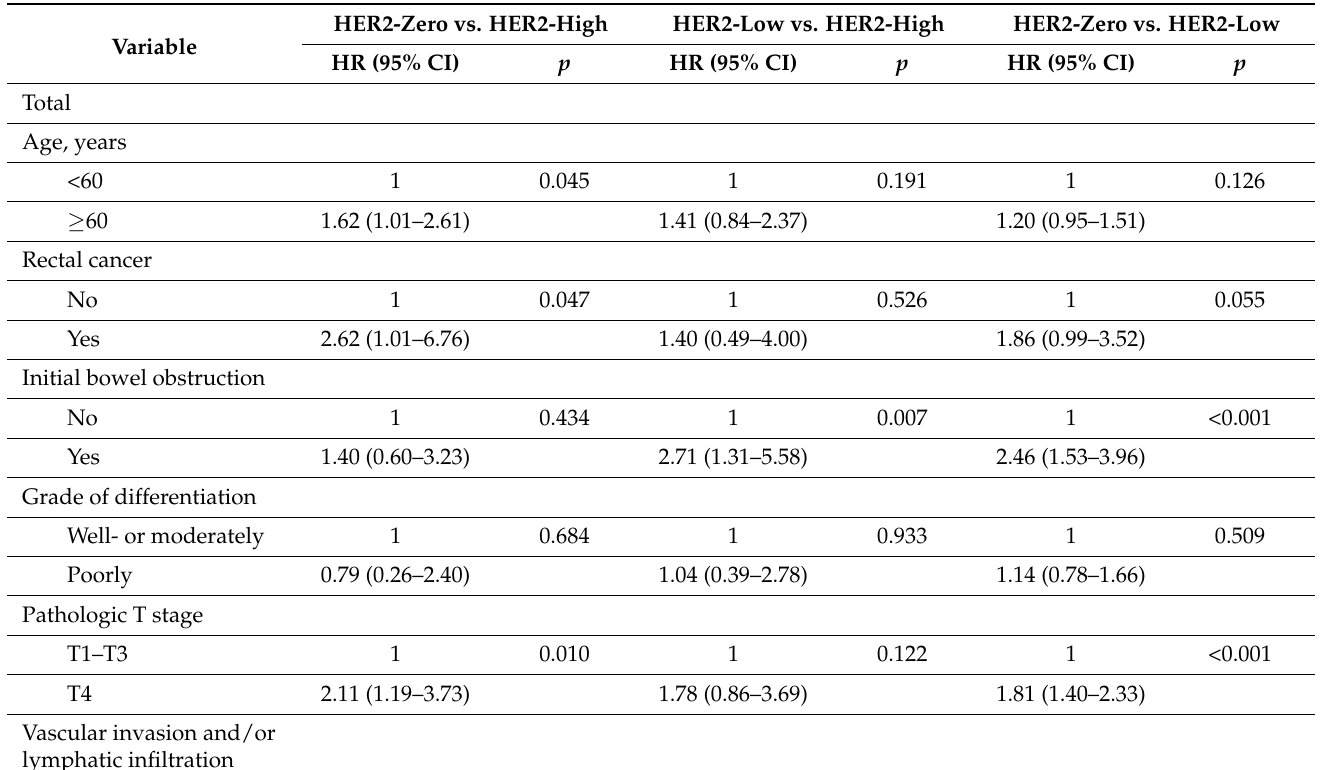
Table 3. Multivariate Cox proportional hazards regression model for disease-free survival in propen- sity score matching